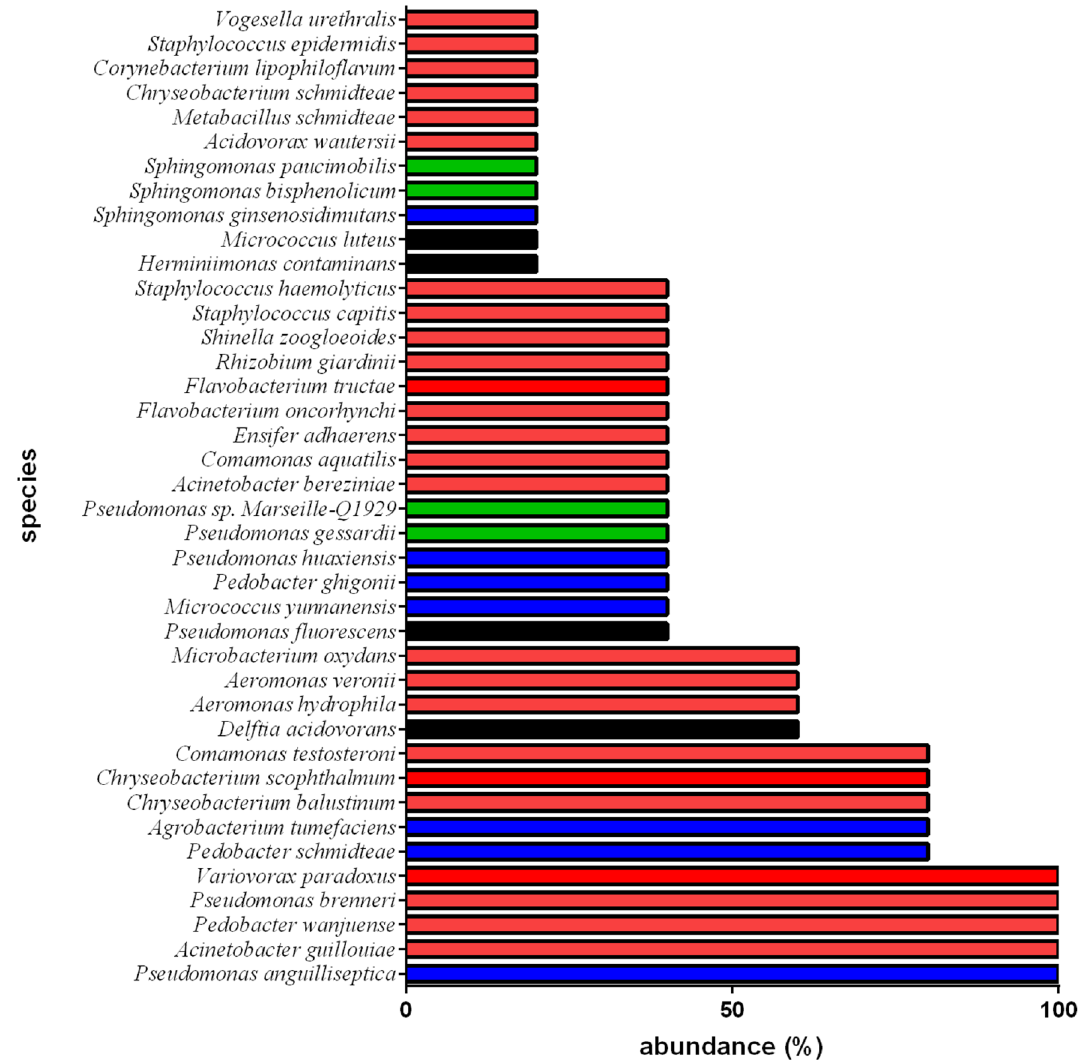
Figure 3. Abundance of the bacterial species identified in the laboratory strain of S. mediterranea starved for 2 weeks. The abundance is expressed as a percentage of the bacterial species. Phyla are shown as follows: Proteobacteria in red, Firmicutes in green, Bacteroidetes in blue, and Actinobacteria in black. Five experiments were each performed on ten individual worms (see also Table S4). Identical results were obtained for each experiment and each worm